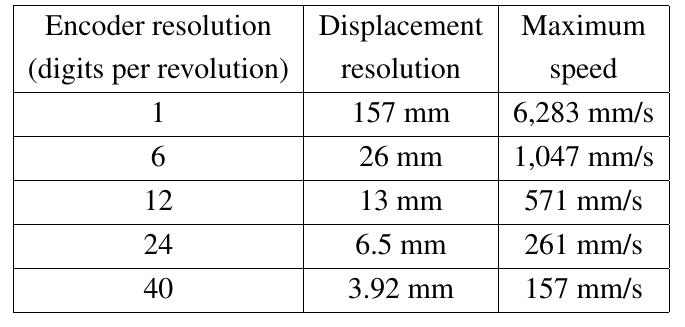
Table 4. Encoder resolution, displacement measurement resolution and maximum speed that can be measured (considering r = 25 mm and s = 40 DTMF digits per second).